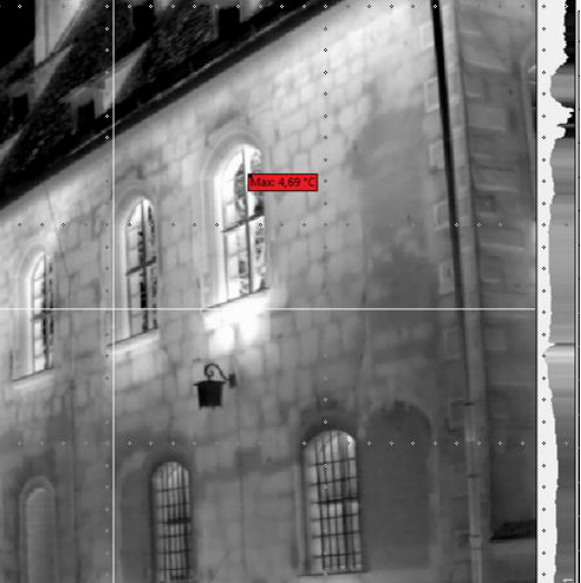
Figure 4: Greyscale visualisation of subsequently walled up openings under